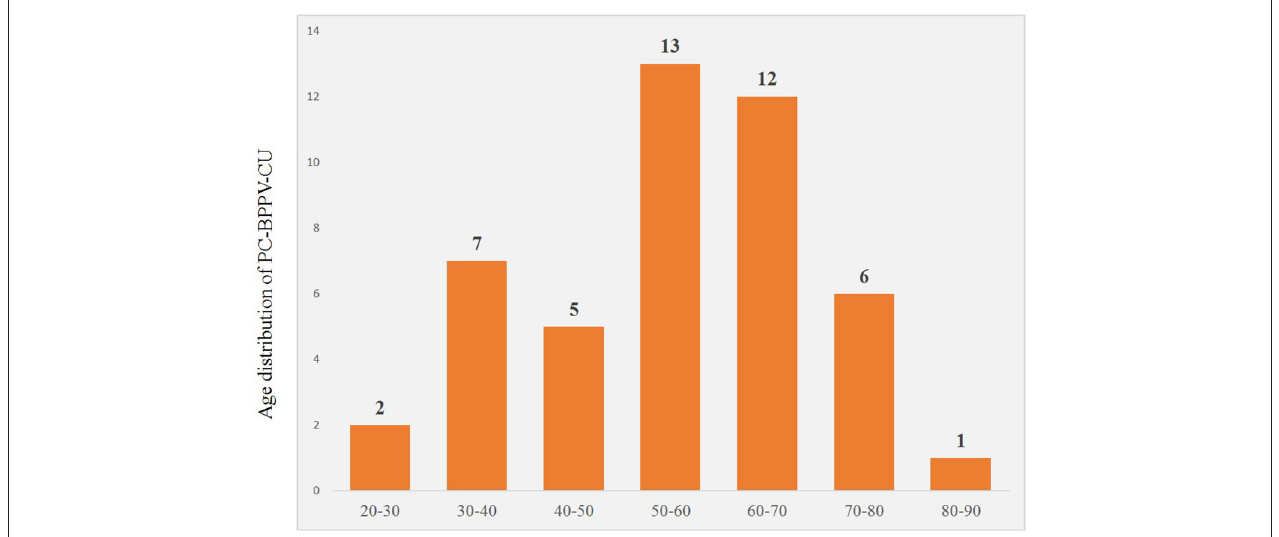
FIGURE 1 | Distribution of torsional nystagmus in three suspension positions in patients with PC-BPPV-cu. UBN, upbeating nystagmus; T-UBN, torsional-upbeating nystagmus.